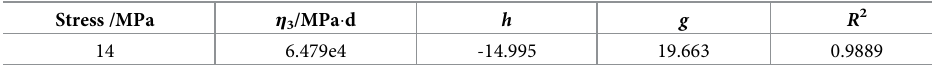
Table 3. Identification table of model parameters in unsteady creep stage.